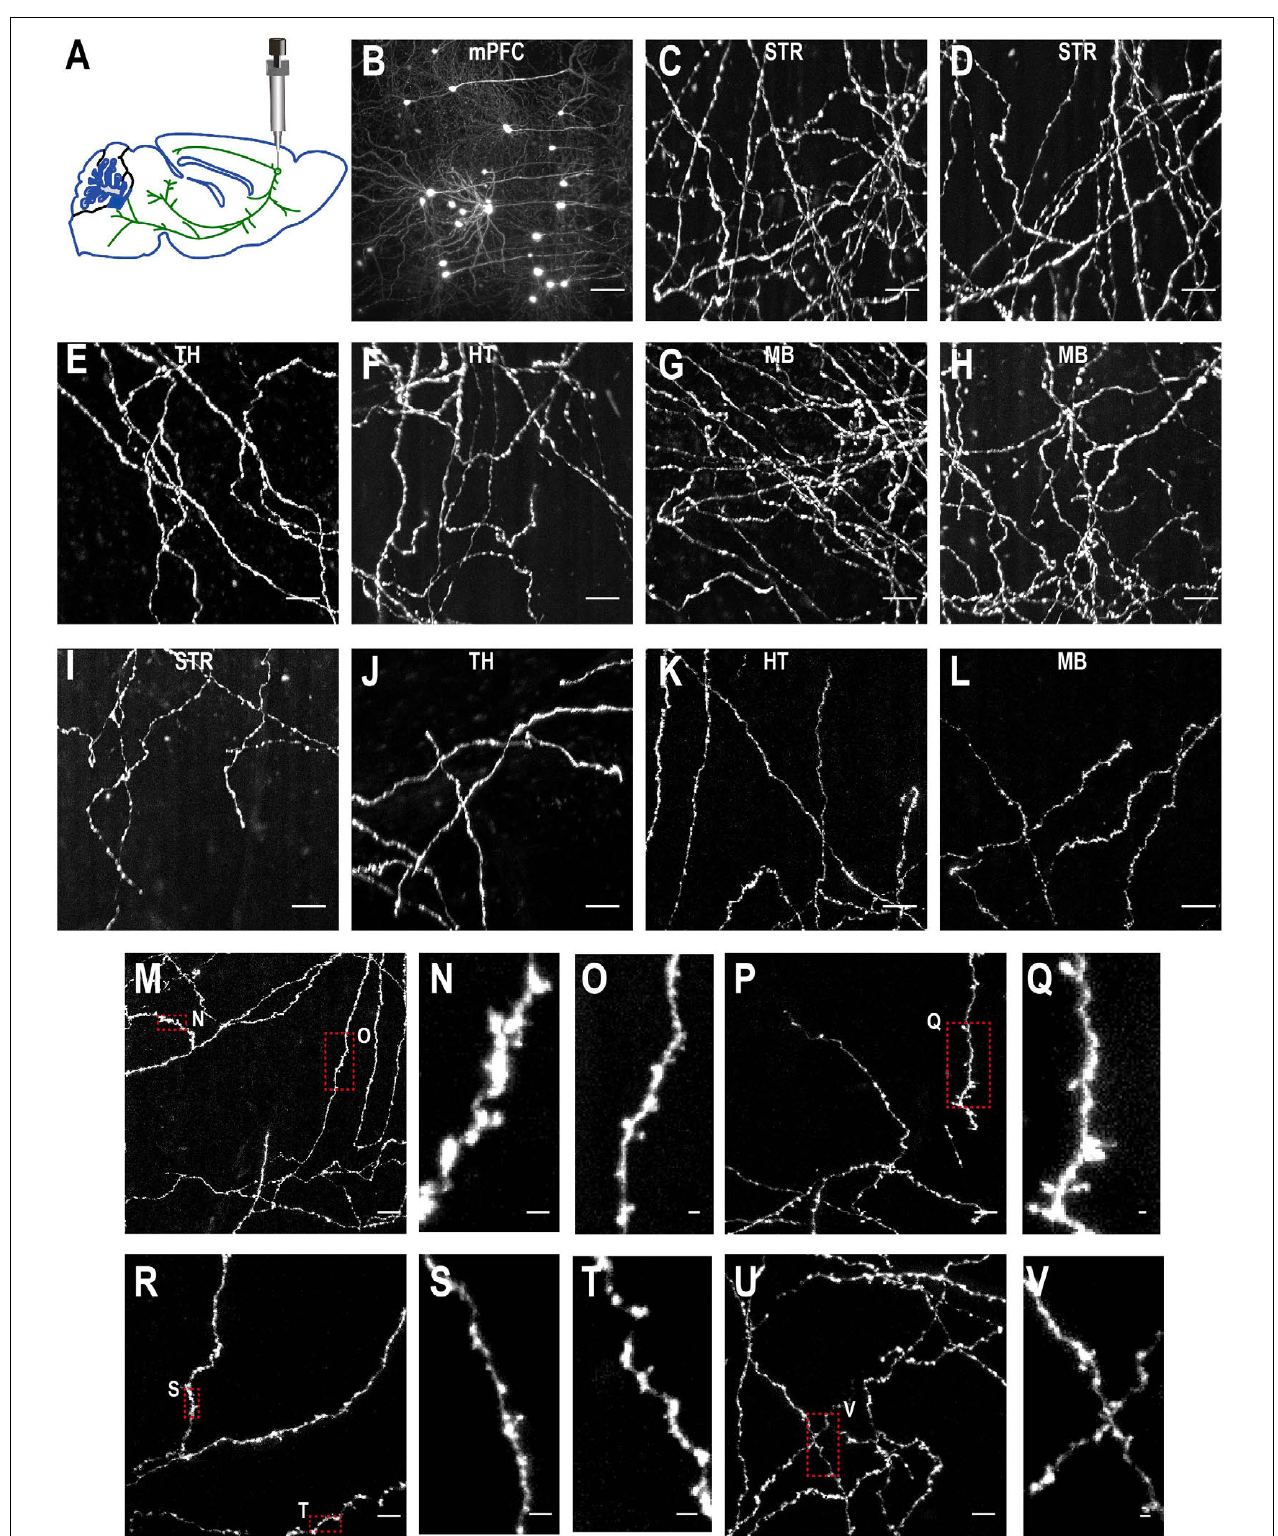
FIGURE 10 | Imaging quality of sparsely labeled mPFC neurons. (A) The top-left figure shows schematic of viral injection in mPFC (AP 1.85, ML 0.4, DV 1.7). Same schematic as in Figure 4K . (B–V) The rest are MIPs of images in selected regions to show labeled somata and neurites. Enlarged view of axon collaterals in red-dotted regions demonstrates high signal-to-noise ratio of the imaging setup. Scale bars, 100 µ m (B) , 50 µ m (C–L,M,P,R,U) , 5 µ m (N,O,Q,S,T,V) .